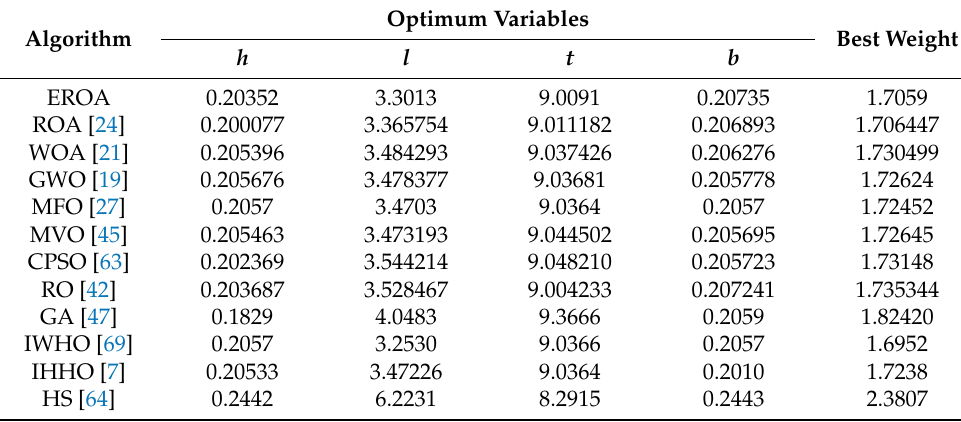
Table 13. Optimization results for the welded beam design